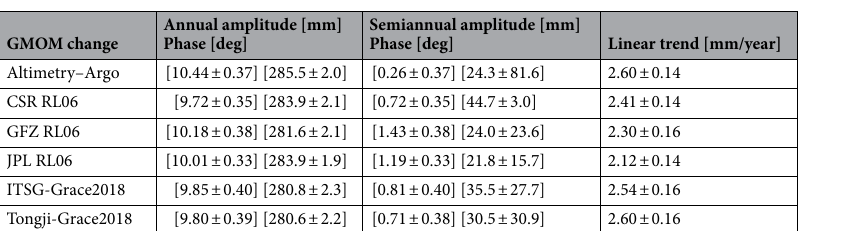
Table 4. Amplitudes and phases of annual and semiannual components and linear trends of GMOM change from altimetry–Argo and GRACE data from January 2005 to December 2016 (no replacing C 20 ).